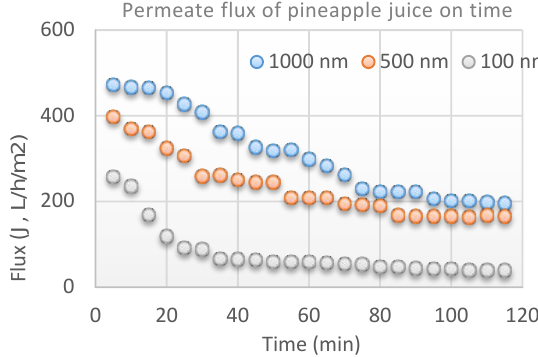
Figure 5. Permeate flux of pineapple juice on time with different membrane pore sizes ( T = 30 °C; TMP = 2 bars). Table 3. Effect of membrane pore size on turbidity of juice.